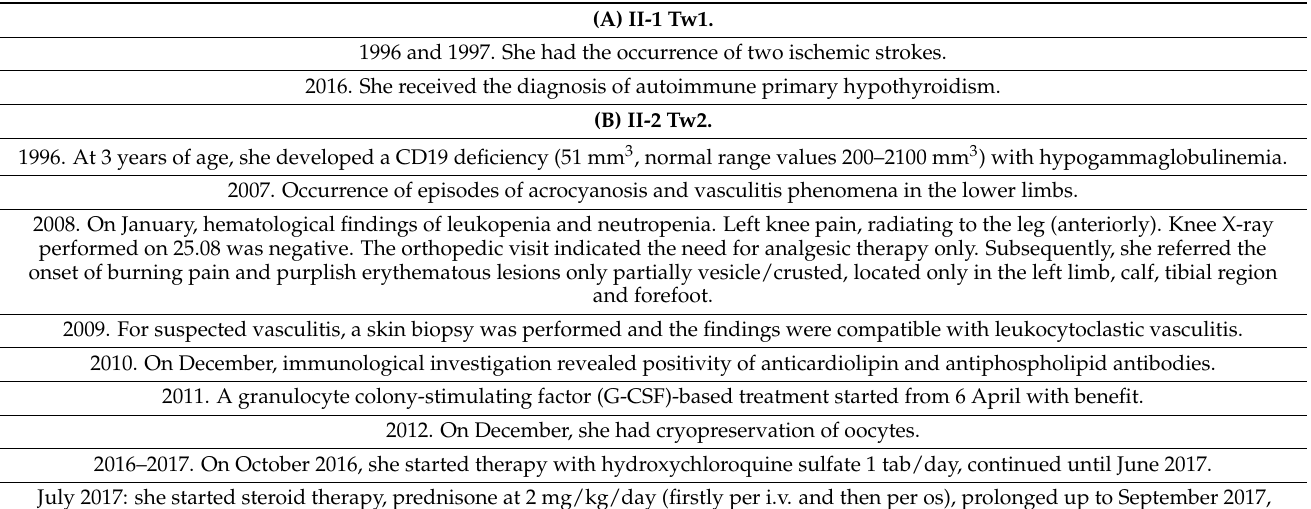
Table 1. Chronological order of bone unrelated abnormalities occurrence [( A ): II-1 Tw1. ( B ): II-2 Tw2]. ( B ) contains also information on therapies performed by II-2 Tw2 in 2016–2018-time